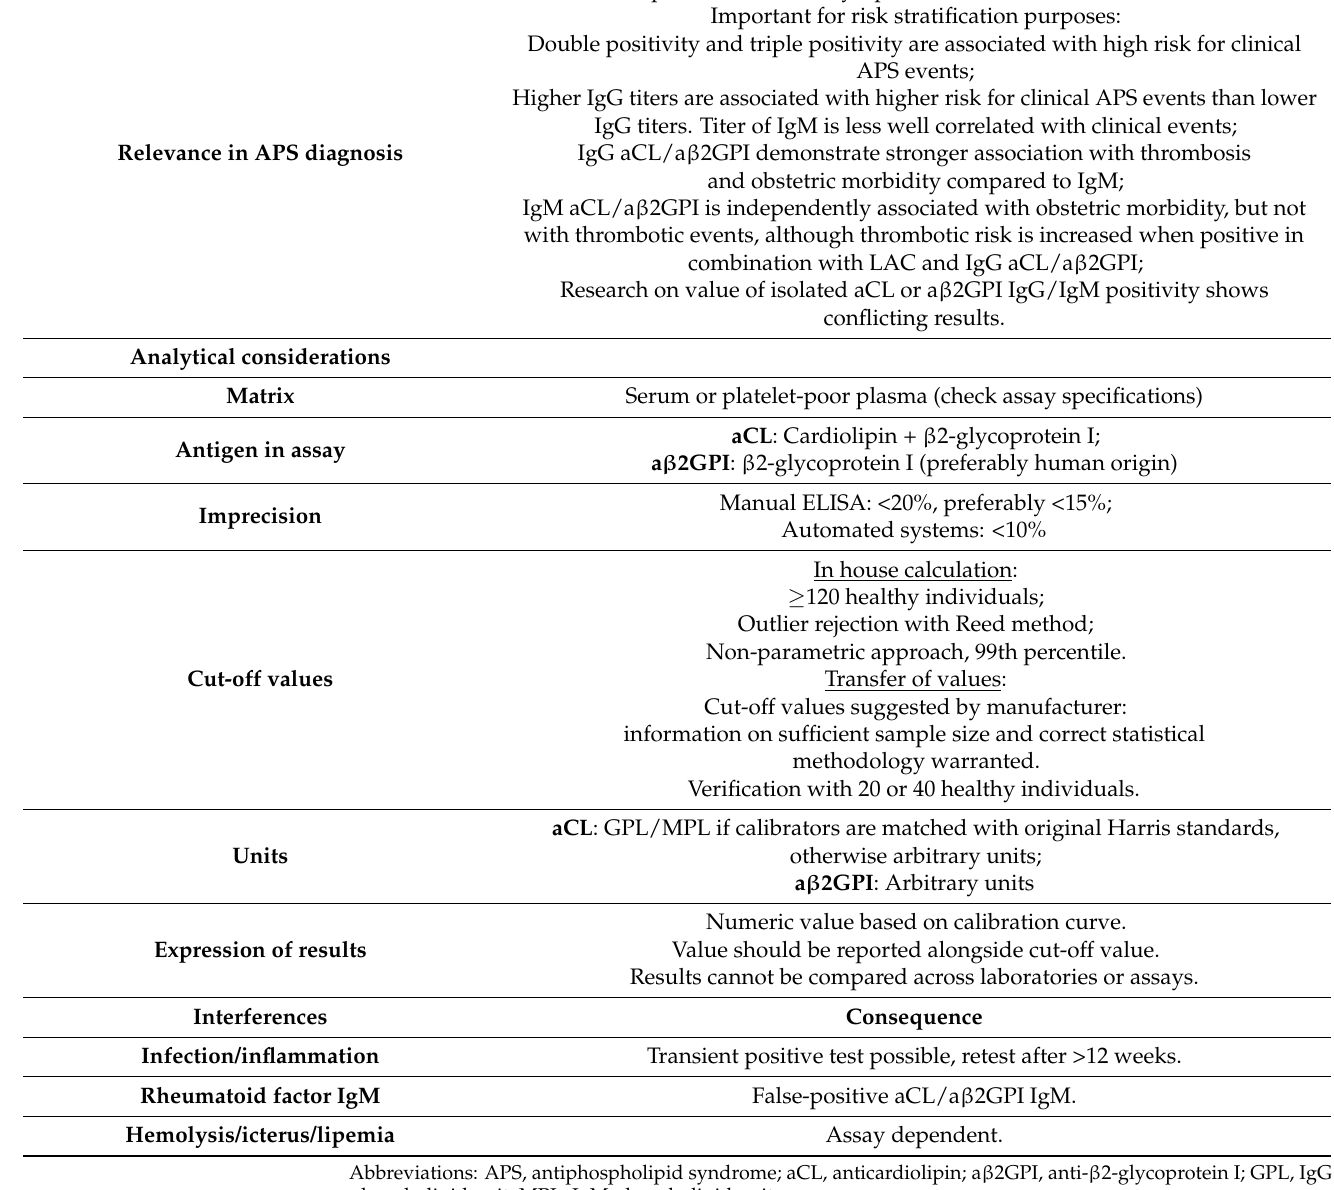
Table 3. Anticardiolipin and anti- β 2 -glycoprotein I IgG and IgM measurement: key messages. Solid-phase immunoassays, part of the APS classification